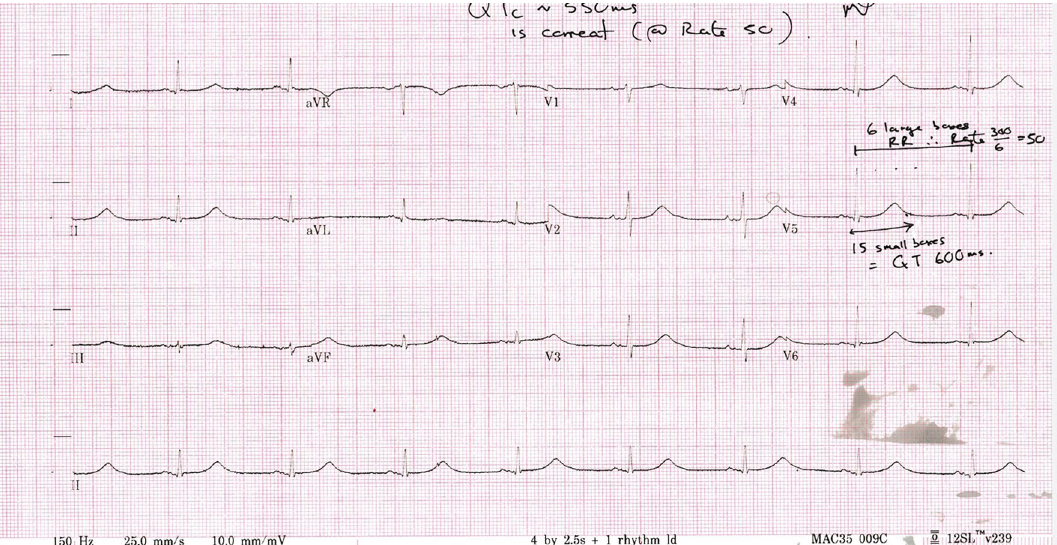
Figure 2: Shows day 2 ECG with a QTc of